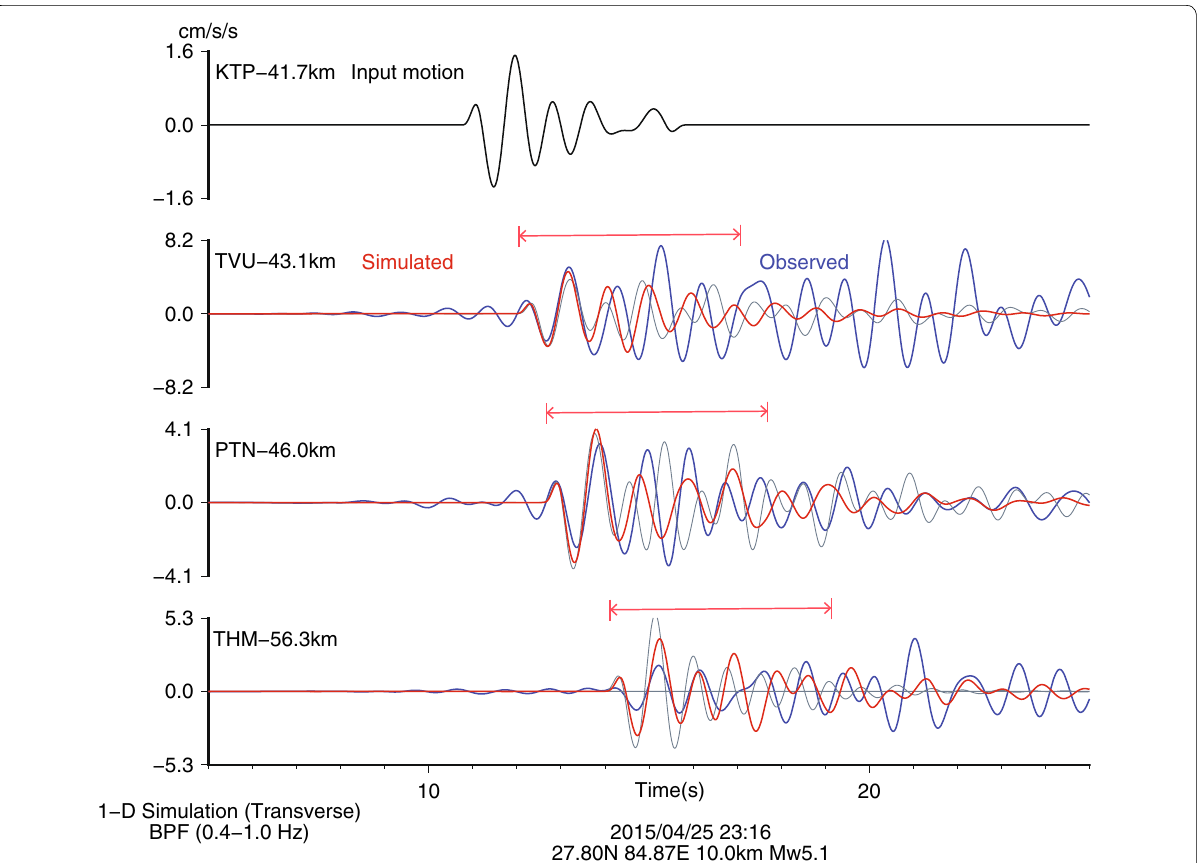
Fig. 10 Simulation of the second Mw5.1 earthquake. The simulated waveforms at TVU and PTN have similar amplitudes with the observed wave- form; however, at THM, the simulation is overestimated. The result from the initial model is also shown, in gray . Waveform matching was conducted using trial and error for time windows indicated by the red